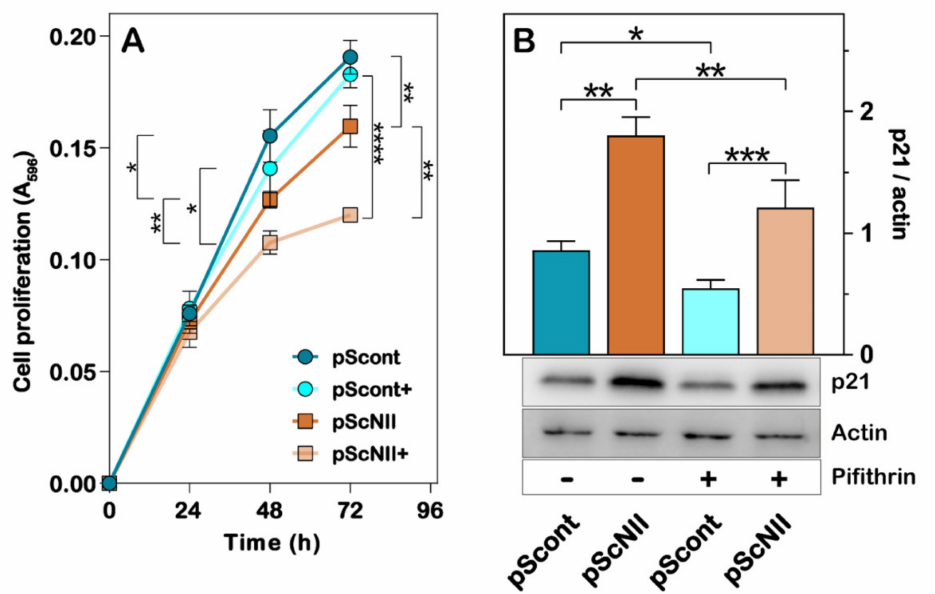
Figure 2. Effect of cN-II silencing on NCI-H292 cell proliferation and p21 expression. ( A ) NCI-H292 pScont and pScNII cell growth with or without 10 µ M pifithrin- α was monitored at 0, 24, 48, and 72 h measuring the absorbance at 596 nm of cells stained with crystal violet. Data are the mean ± SD of two experiments performed in sextuplicate. ( B ) The subfigures are representative images of the densitometries shown in the bar graphs for p21. NCI-H292 pScont and pScNII cells were cultured with or without 10 µ M pifithrin- α for 48 h and expression of p21 was analyzed as described in Materials and Methods. β -actin was used as loading control. The ratio between the intensity of the p21 and actin bands was calculated and the results are expressed as the mean ± SD of three independent experiments. * p < 0.05, ** p < 0.01, *** p < 0.001, **** p <